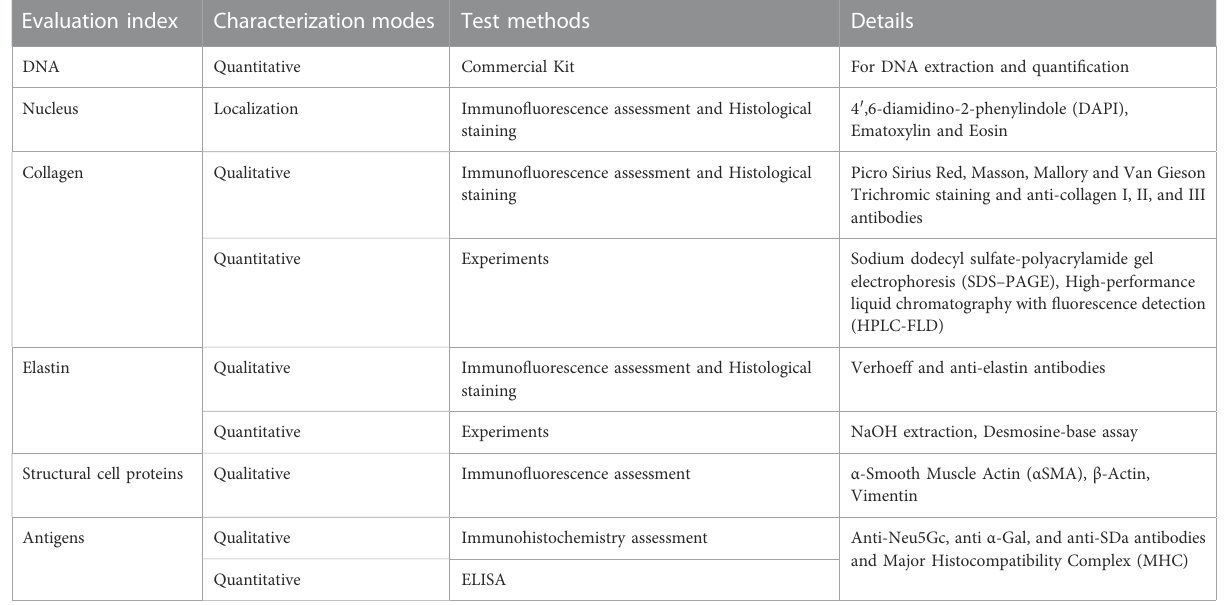
TABLE 2 Common test methods for evaluation of the decellularization effect.